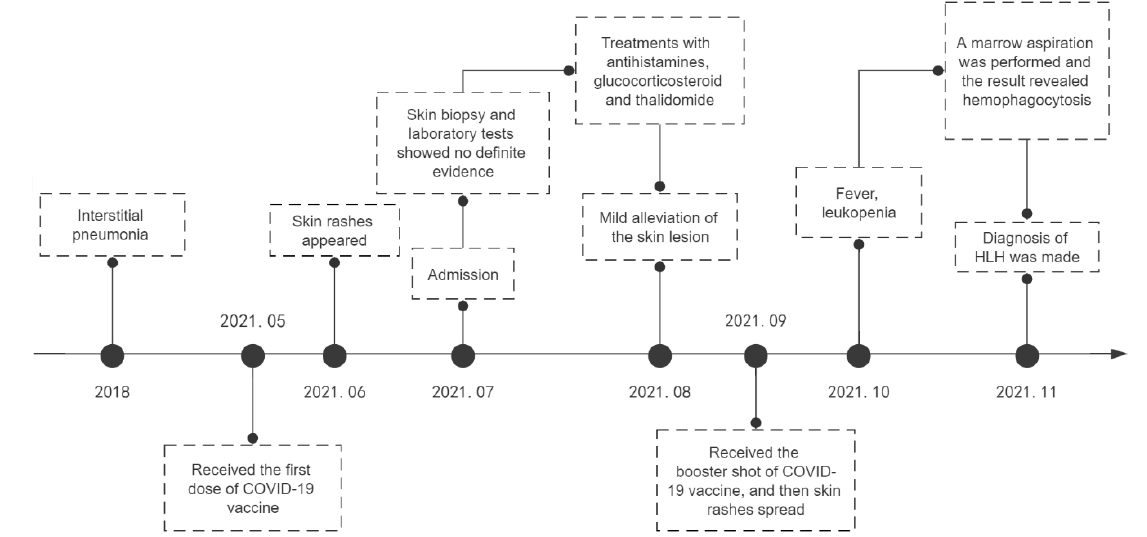
Figure 3. A coherent timeline indicating the date of this